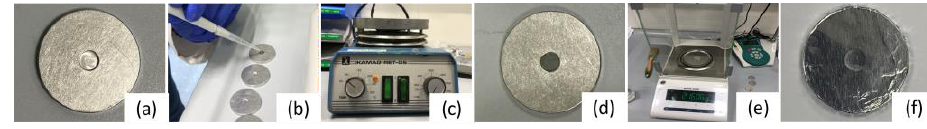
Fig. 4. Preparation of a target for cross section measurements: (a) empty aluminum disk; (b) sedimentation procedure; (c) heating plate; (d) aluminum disk filled with target material; (e) analytical balance; (f) aluminum disk covered with a thin aluminum